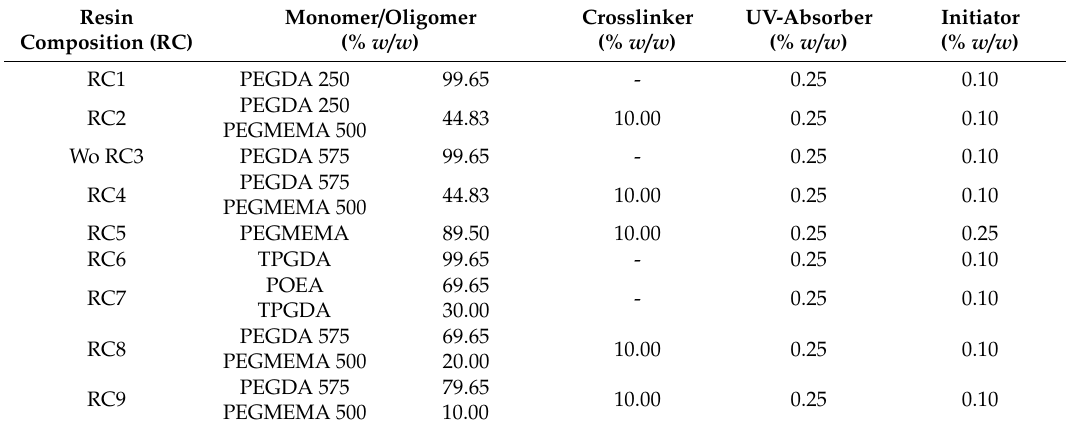
Table 1. The resin composition of nine di ff erent resins containing monomers / oligomers, crosslinker, ultraviolet (UV)-absorber, and